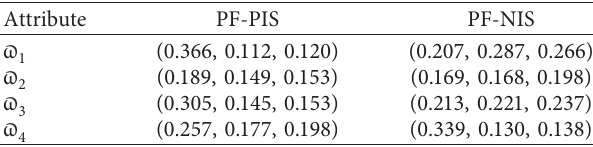
Table 19: PF-PIS and PF-NIS values.